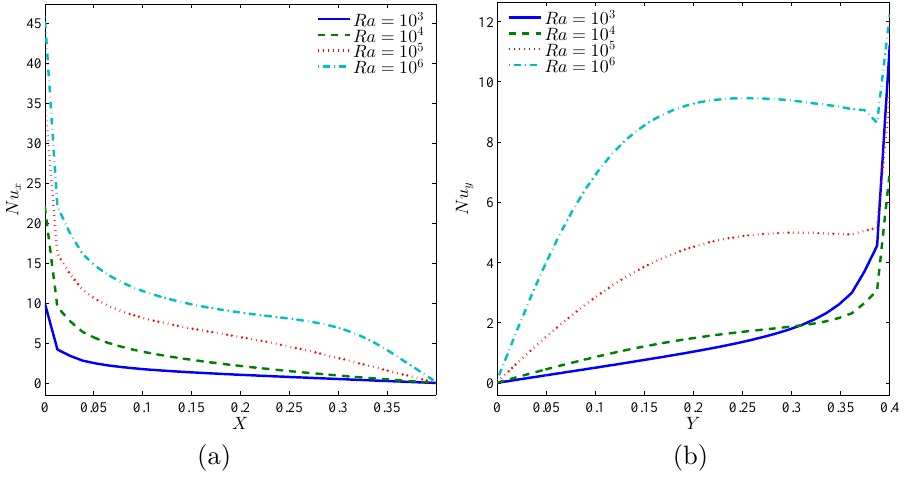
Figure 10. Variations of the local Nusselt numbers along ( a ) the bottom side wall ( X ) and ( b ) the left side wall ( Y ) for different Ra at φ = 0.02, k w = 0.76 and D = 0.3.